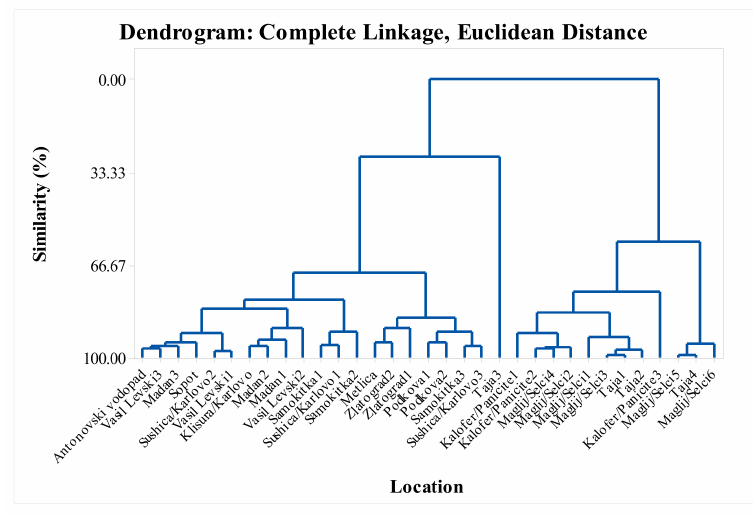
Figure 4. Complete linkage dendrogram showing the similarity of 33 locations in terms of myrcene, α -terpinene, p -cymene, γ -terpinene, thymol, carvacrol, trans -caryophyllene, and caryophyllene oxide of Satureja pilosa